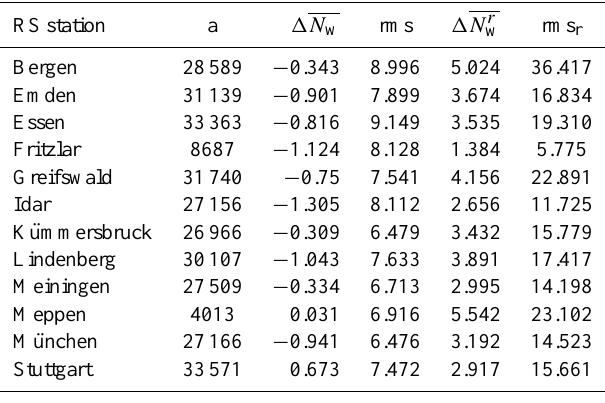
Table 1. Number of unused profiles according to different criteria. Table 2. Statistics of the differences between radiosonde and GPS tomography; a is the number of observations. 1N w and rms are the average difference of N w between radiosonde and tomography and its root mean square. 1N r w and rms r are the average and root mean square of the relative